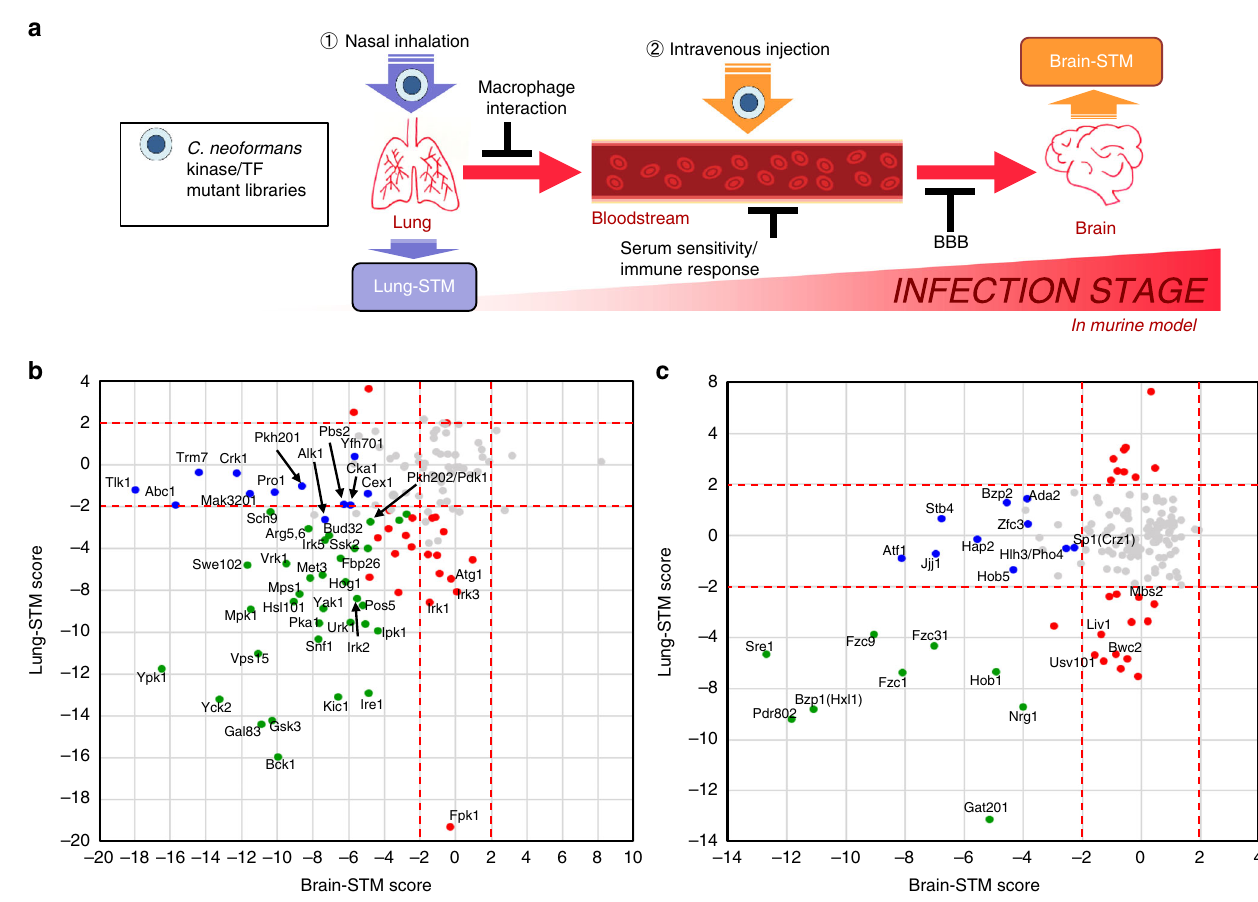
Fig. 1 Dual signature-tagged mutagenesis (STM) analyses of kinase and TF deletion libraries of C. neoformans . ( a ) A schematic diagram for comparison of lung (via intranasal infection) and brain (via intravenous infection) STM analysis using C. neoformans TF and kinase mutant libraries 15,16 . ( b - c ) Lung-STM scores for each mutant were obtained from the previous reports using a intranasally infected murine model (A/J mice, n = 3). Brain-STM scores were obtained in this study using the A/J mouse model intravenously infected with the same set of TF and kinase mutant libraries (the whole data were shown in Supplementary Fig. 2). Dual STM scores of ( b ) 129 kinases and ( c ) 155 TFs were represented by brain-STM score (X-axis) and lung-STM score (Y-axis). Each spot was an average STM score of two-independent TF or kinase mutant strains, each of which was obtained from three mice ( n = 3). We used the colour code for kinase/TF mutants that exceeded STM cutoff [>2.0 (high) or < − 2.0 (low)] and had statistically signi fi cant P values (<0.05) by one-way ANOVA analysis with Bonferroni ’ s multiple comparison test. Green dots indicate the core-virulence kinase/TF mutants that show low/high STM scores in both lung- and brain infections. Blue dots indicate the kinase/TF mutants that show low/high STM scores only in brain-infection. Red dots indicate the kinase/TF mutants that show low/high STM only in lung